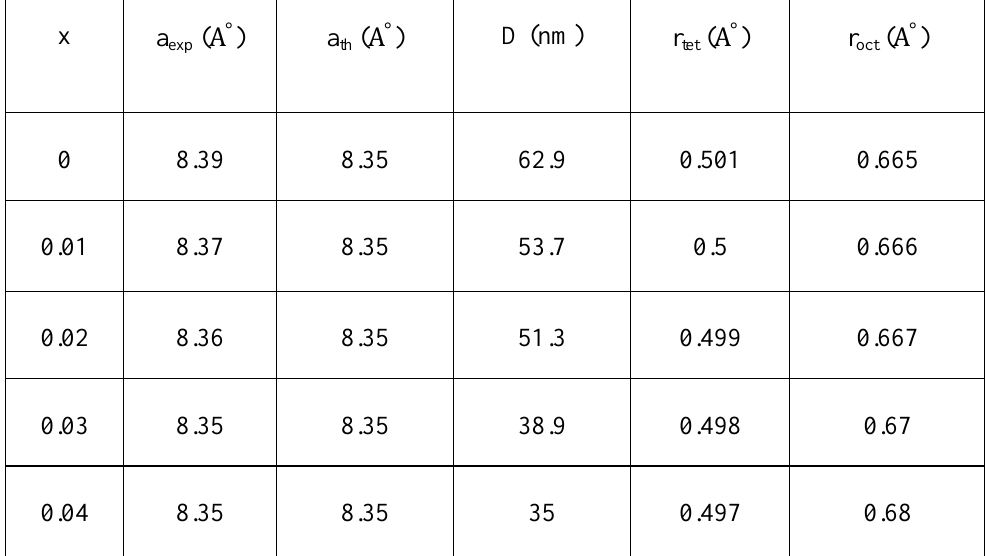
Table 1: XRD pattern analysis of Li doped Ni-Zn ferrite. Experimental and theoretical lattice constant, crystallite size and the radius of the tetrahedral and octahedral